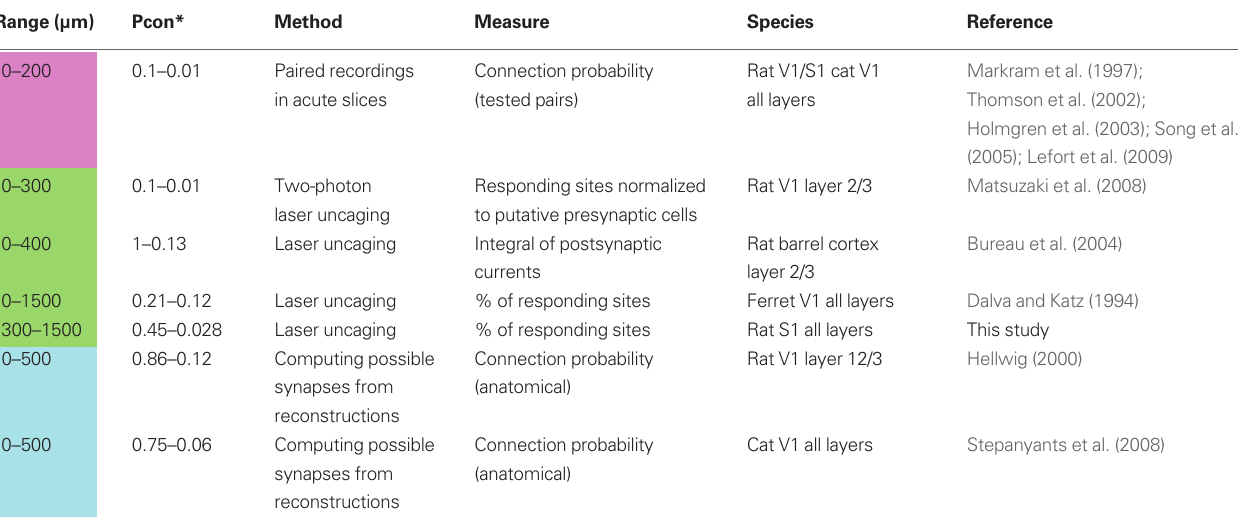
( d ) within the con